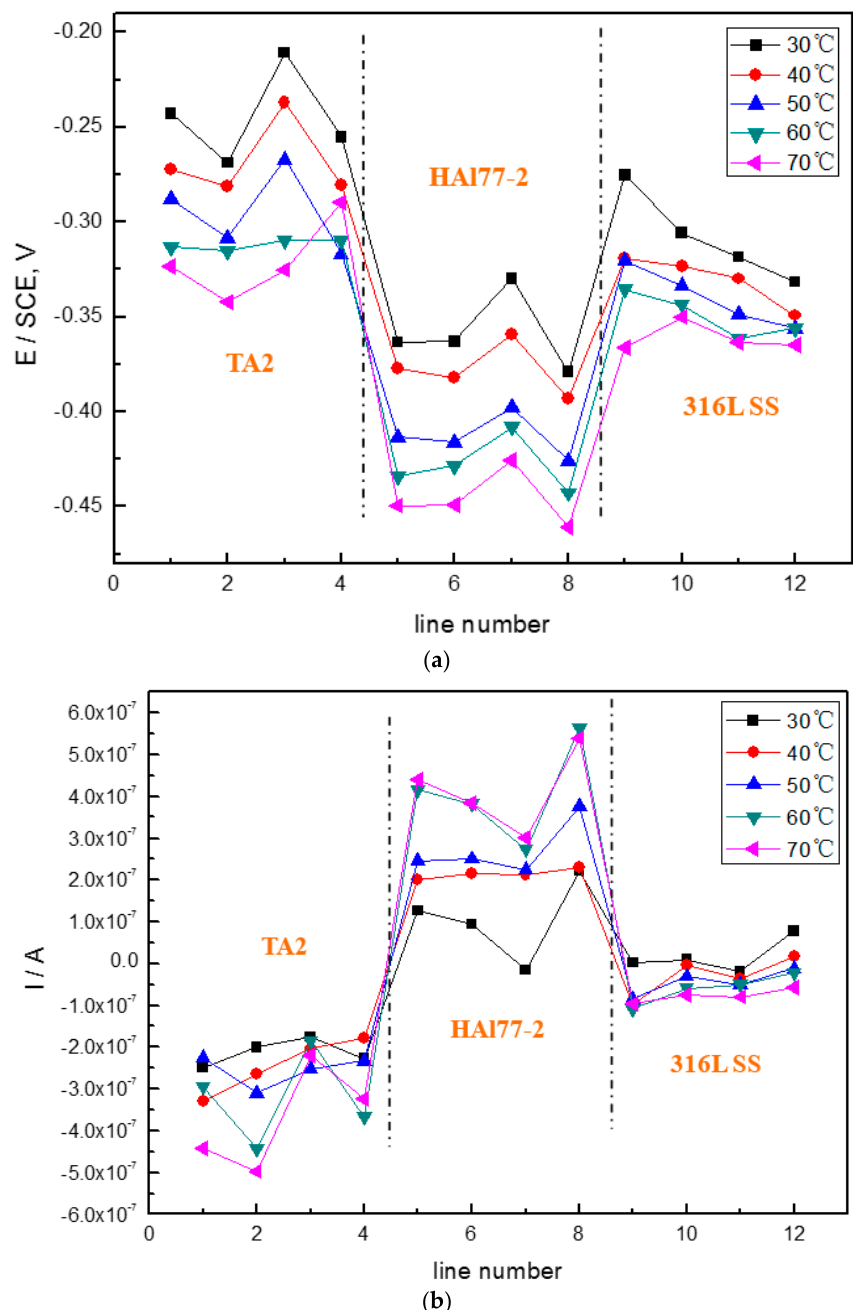
Figure 14. ( a ) Average local potential; and ( b ) current–density distributions of each WBE3 microelectrode line after being short-circuited for 12 h in artificial seawater at different temperatures.